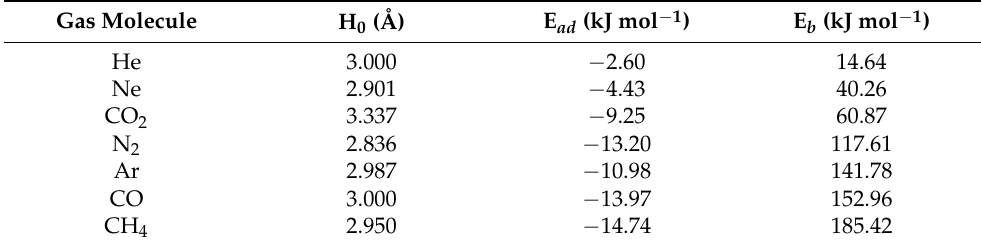
Table 1. The adsorption height (H 0 ), the corresponding adsorption energy (E ad ) between the gas molecule and the Fe-PTC monolayer, and the energy barriers (E b ) of the seven gas molecules translo- cating the Fe-PTC monolayer.